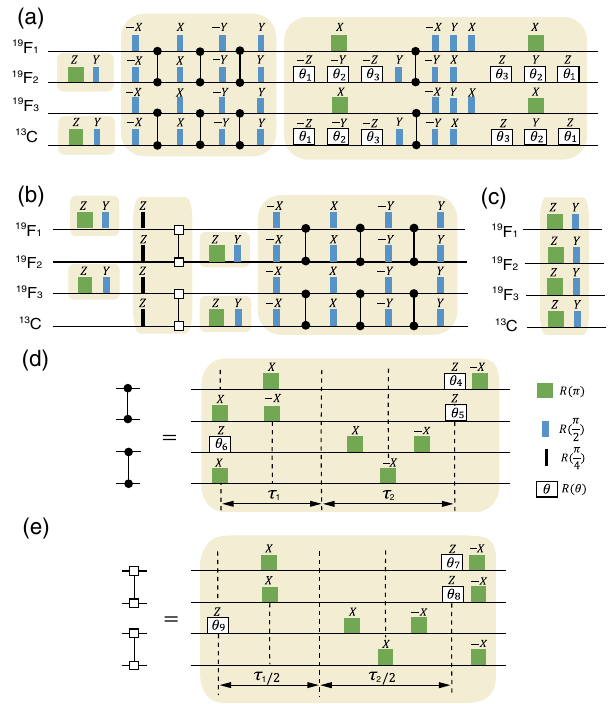
FIG. 4. Pulse sequences for implementing the (a) Haar, (b) Fourier, (c) Hadamard image transform, (d) the operation e ½ − i ð I 1 z I 2 z þ I 3 z I 4 z Þ π (cid:2) , and (e) e ½ i ð I 1 z I 2 z þ I 3 z I 4 z Þ π = 2 (cid:2) . Here, τ 1 ¼ j 1 = 2 J 34 j and τ ¼ j 1 = 2 J j − j 1 = 2 J j , respectively. The rectangles represent 2 12 34 the rotation R ð θ Þ with the phases given above the rectangles. The rotation angles θ 1 ¼ − 0 . 1282 π , θ 2 ¼ − 0 . 2634 π , θ 3 ¼ 0 . 0894 π , θ ¼ − 2 πν τ θ ¼ − 2 πν τ θ ¼ − 2 πν τ θ ¼ θ 2 , 4 1 2 , 5 2 2 , 6 3 1 , 7 4 = θ ¼ θ 2 , and θ ¼ θ 2 . The time order of the pulse sequence 8 5 = 9 6 = is from left to